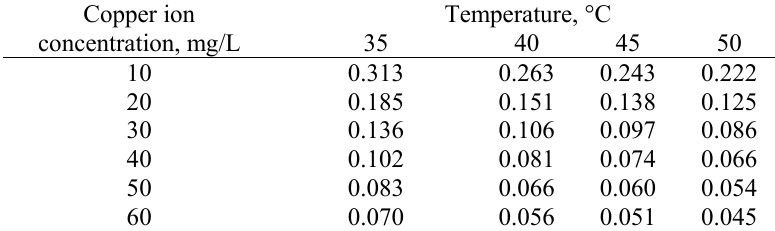
) for the adsorption of copper ion by CBC L Temperature, °C Copper ion